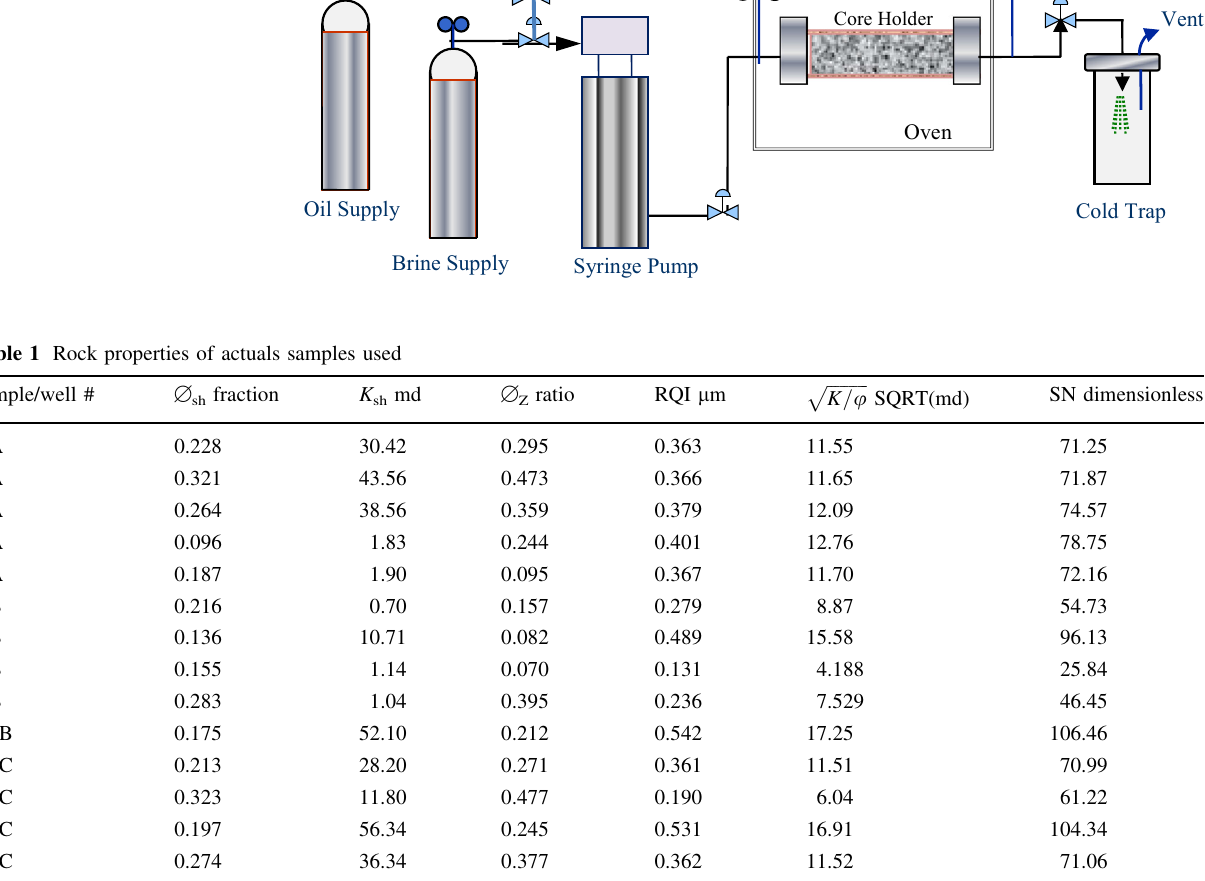
Fig. 1 Experimental core flooding system